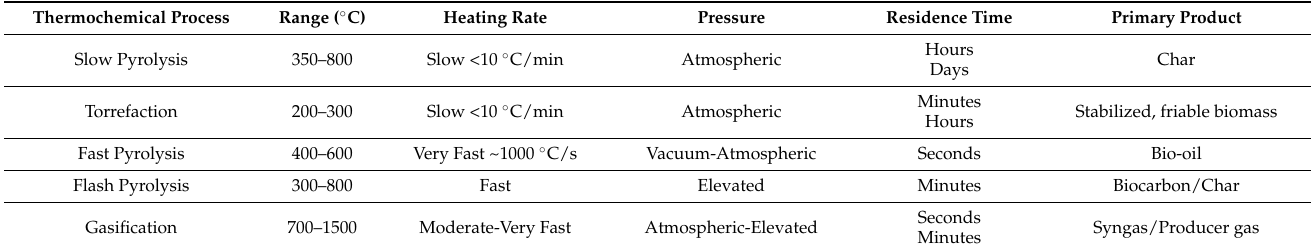
Table 1. Specifications for thermochemical processes